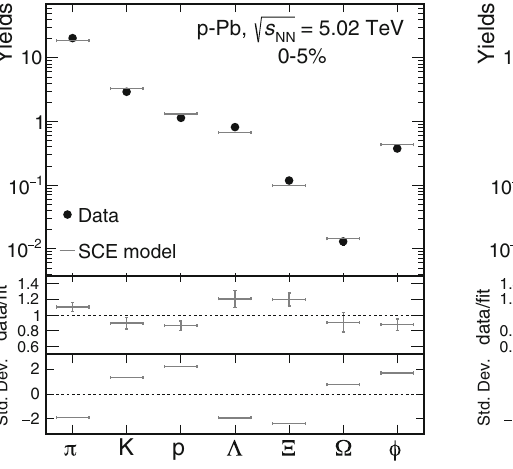
Fig. 2 Comparison of data with fits for the two most central